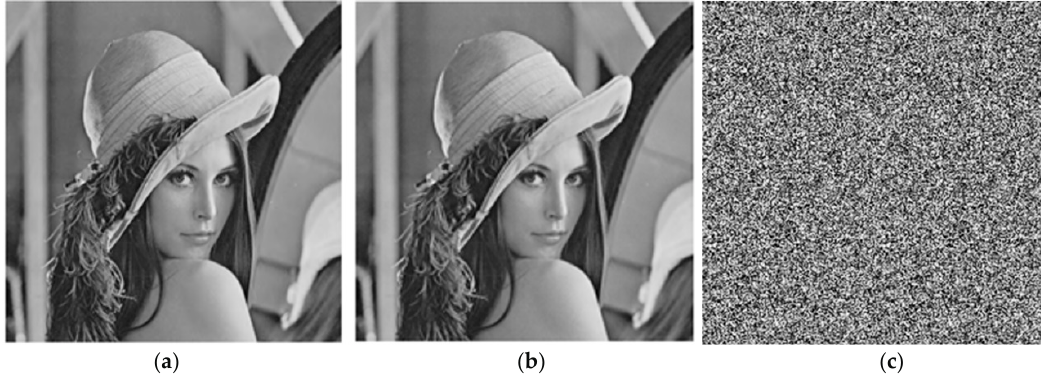
Figure 7. Experimental results. ( a ) Lena original grayscale image; ( b ) Lena reconstructed image; ( c ) Reconstructed with an incorrect key value.